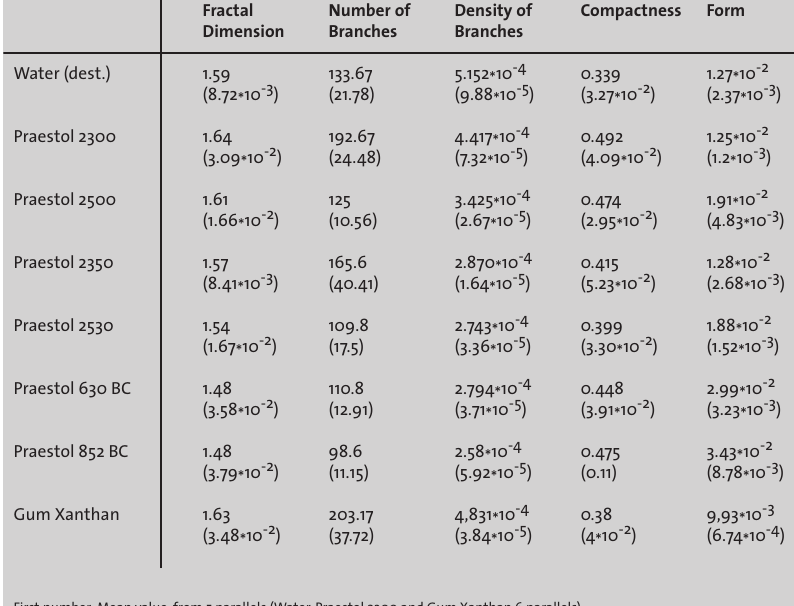
Table 2: Mean values and standard deviation of fractal dimension, number of branches, density of branches, compactness and